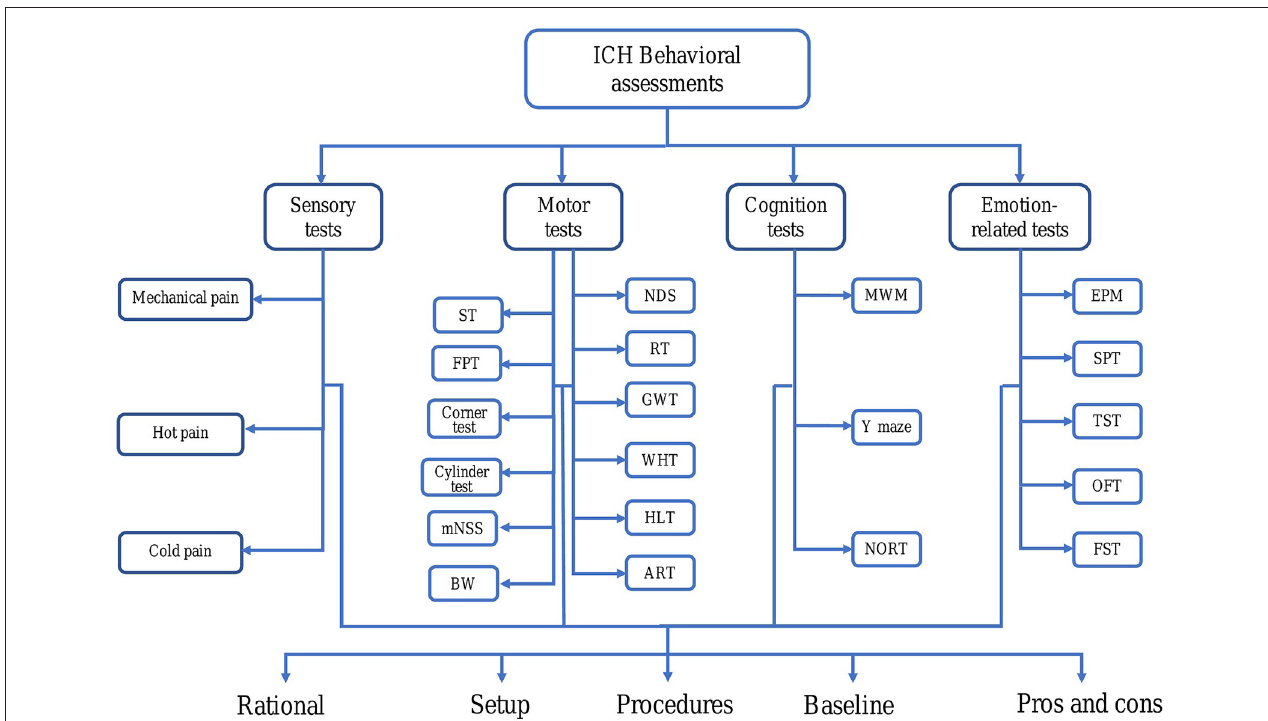
FIGURE 1 | Abnormal behavior after intracerebral hemorrhage (ICH) in rodents. For each behavioral testing, we discussed several aspects, such as rationale, setup, duration, baseline, procedures as well as comparing their pros and cons. ART, Adhesive removal test; BW, Beam walking; EPM, Elevated plus maze; FPT, Forelimb placing test; FST, Forced swim test; GWT, Grid walk test; HL, Horizontal ladder; ICH, Intracerebral hemorrhage; MWM, Morris water maze; mNSS, Modified neurological severity score; NDS, Neurological deficit scale; NORT, Novel object recognition test; OFT, Open field test; RT, Rotarod test; SPT, Sucrose preference test; ST, Staircase test; TST, Tail suspension test; WHT, Wire hanging